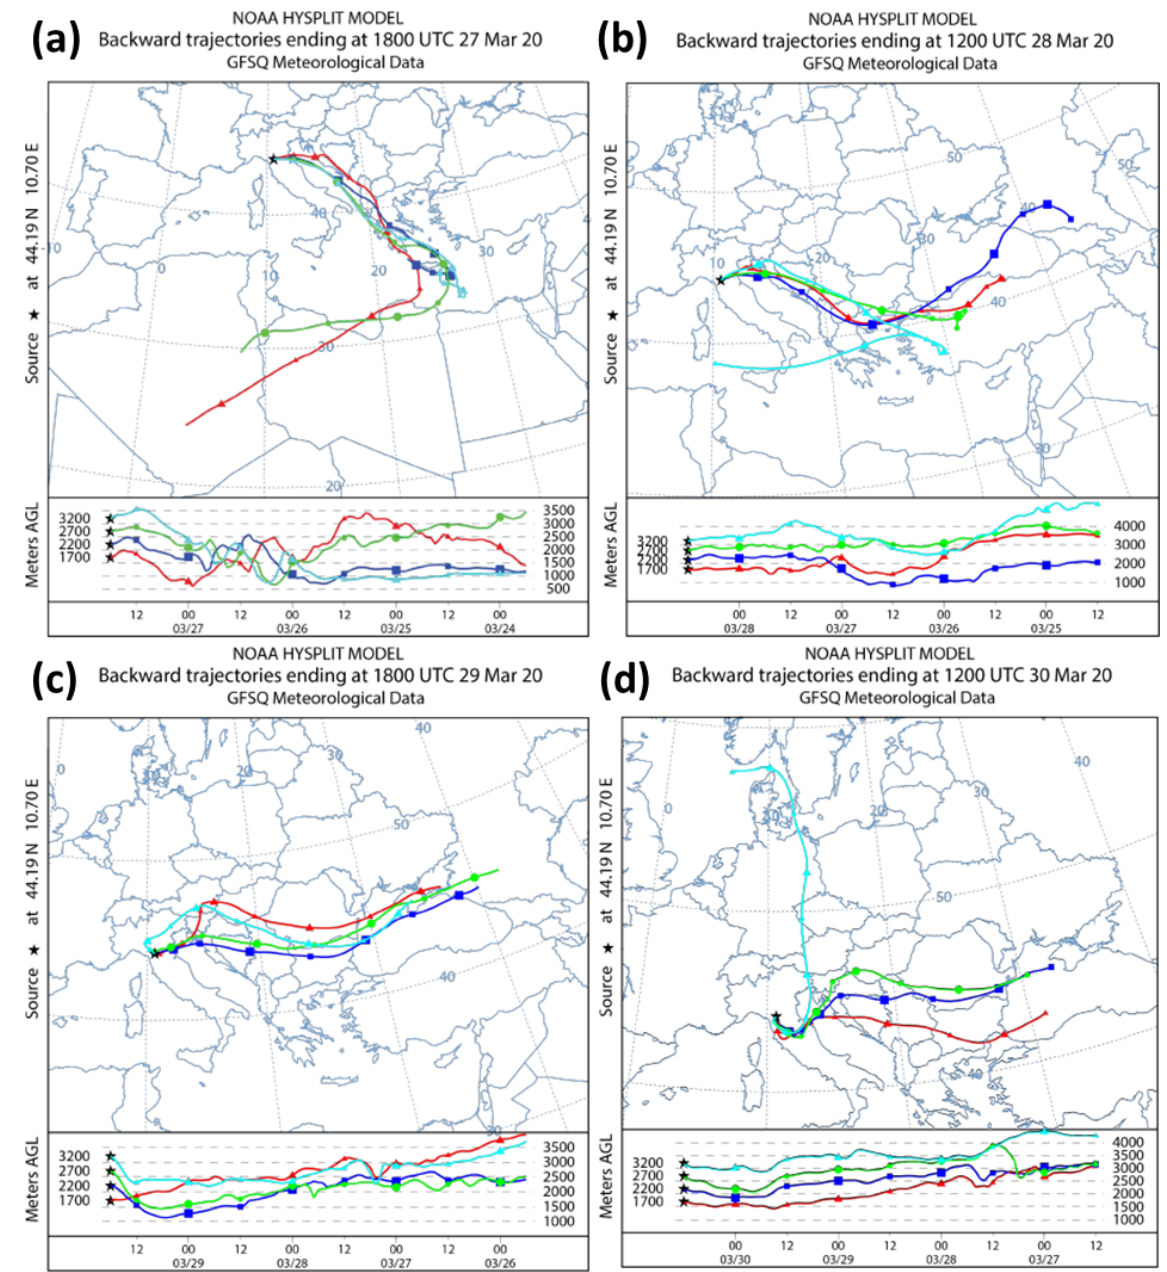
Figure A3. Back trajectories (96h backwards) ending at Mt. Cimone on (a) 27 March at 18:00UTC, (b) 28 March at 12:00UTC, (c) 29 March at 18:00UTC, and (d) 30 March at 12:00UTC.